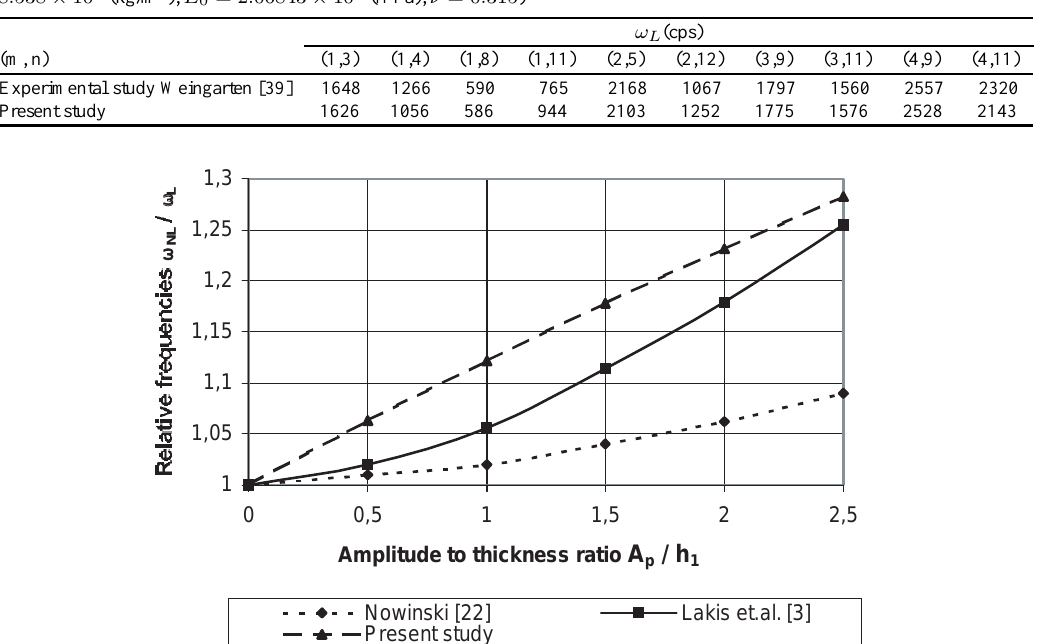
Table 4 Comparison of experimental frequency spectra of a monocoque cylindrical shell ( R/h 1 = 400 , L/R = 0 . 465 , ρ 0 = 8 . 538 × 10 3 (kg/m 3 ), E 0 = 2 . 06843 × 10 5 (MPa), ν = 0 . 315 )